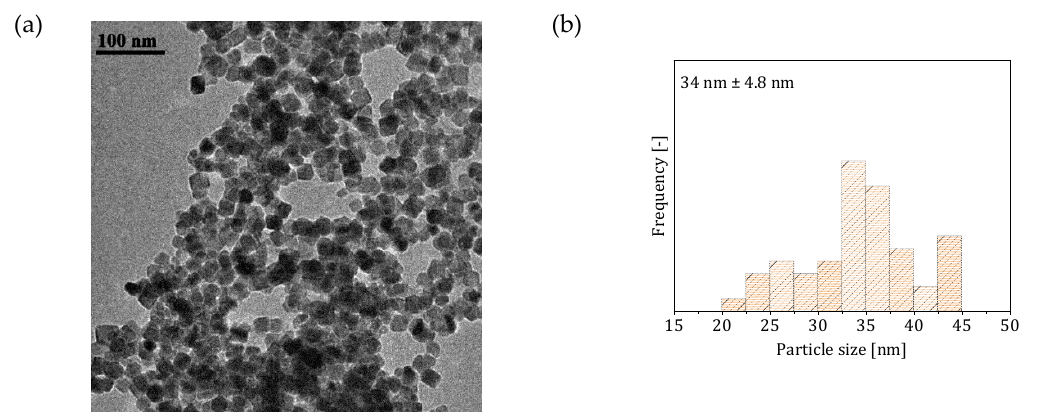
Figure 4. ( a ) TEM micrograph and ( b ) particle size distribution of particles obtained from Reactor System 3.